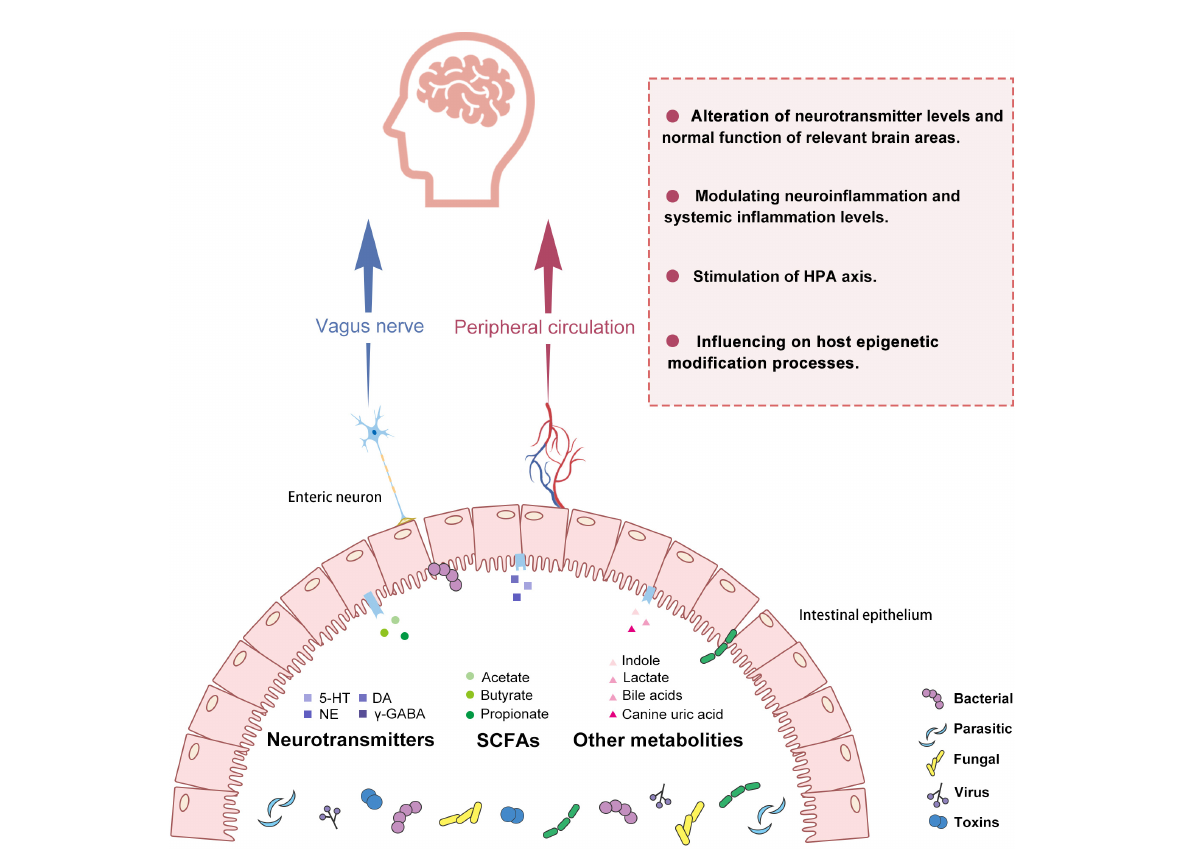
FIGURE1 Potential pathways for gut microbiota to make connections with the brain in depression. GM and its metabolites include SCFAs, neurotransmitters, etc., which can act as a bridge to transmit information from the gut to the brain. This communication consists mainly of neural and humoral pathways. On the one hand, it can affect neuroimmune and neuroendocrine mechanisms closely related to the vagus nerve. On the other hand, GM and its metabolites can also cross the intestinal barrier and enter the systemic circulation to modulate host neurotransmitter levels, the immune system, the endocrine system, and epigenetic processes. GM, gut microbiota; 5HT, 5-hydroxytryptamine; DA, Dopamine; NE, Norepinephrine; γ -GABA, Gamma-aminobutyric acid; SCFAs, short-chain fatty acids; HPA, hypothalamic-pituitary-adrenal